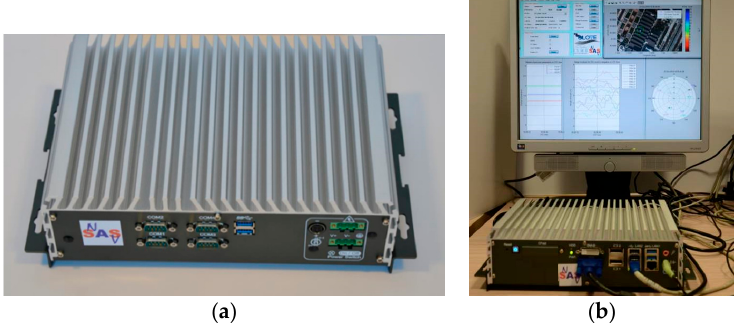
Figure 11. Proof-of-concept demonstrator: ( a ) selected car PC for the demonstrator. ( b ) Car PC properly configured for running the local integrity software and GUI in real-time.